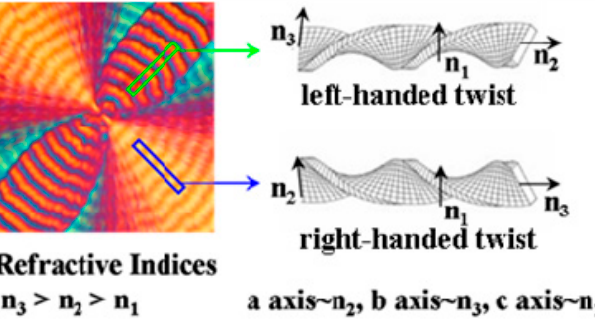
Figure 13. Scheme of the two radial growth directions and twist senses in the normal region and the eye-like region of the PHV spherulite. In the eye-like region, the radial direction is along the a axis with left-handed lamellar twisting. In the other region, the radial direction is along the b axis with right-handed twisting. Adapted with permission from Ref. [17]. Copyright (2009) American Chemical Society.